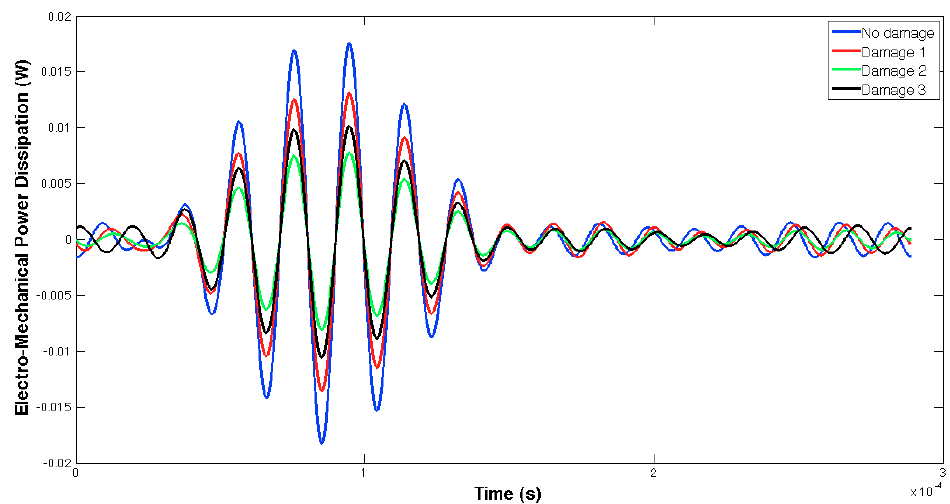
Figure 6. EMPD at 50 kHz. Tone-burst sent from sensor 2 to sensor 1.